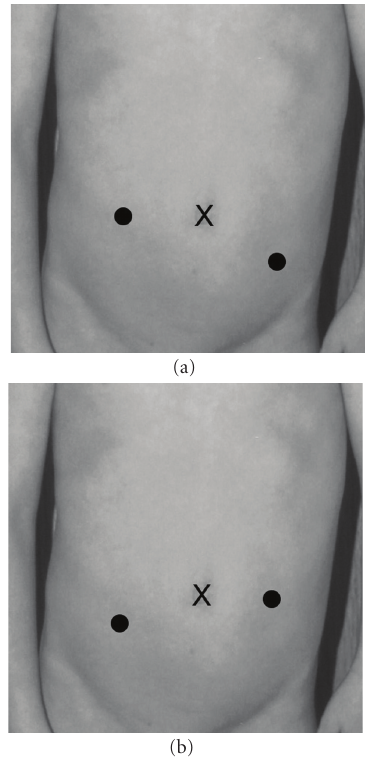
Figure 2: (a) Port placement, right reimplant; (b) port placement, left